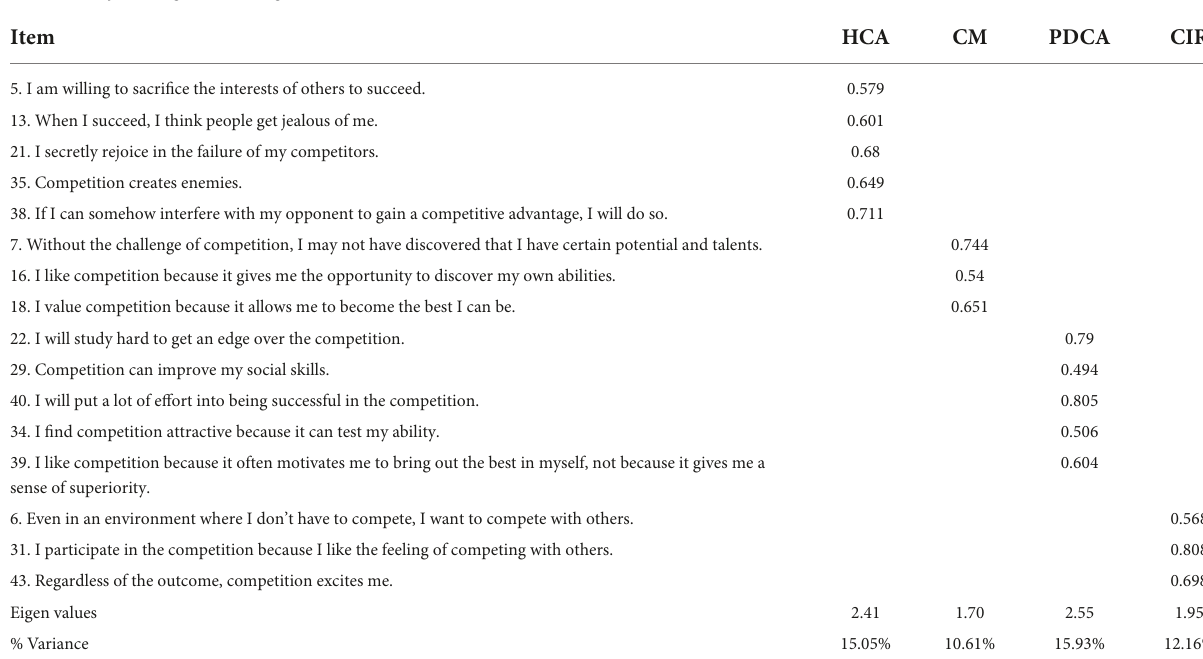
TABLE 1 Exploratory factor analysis of